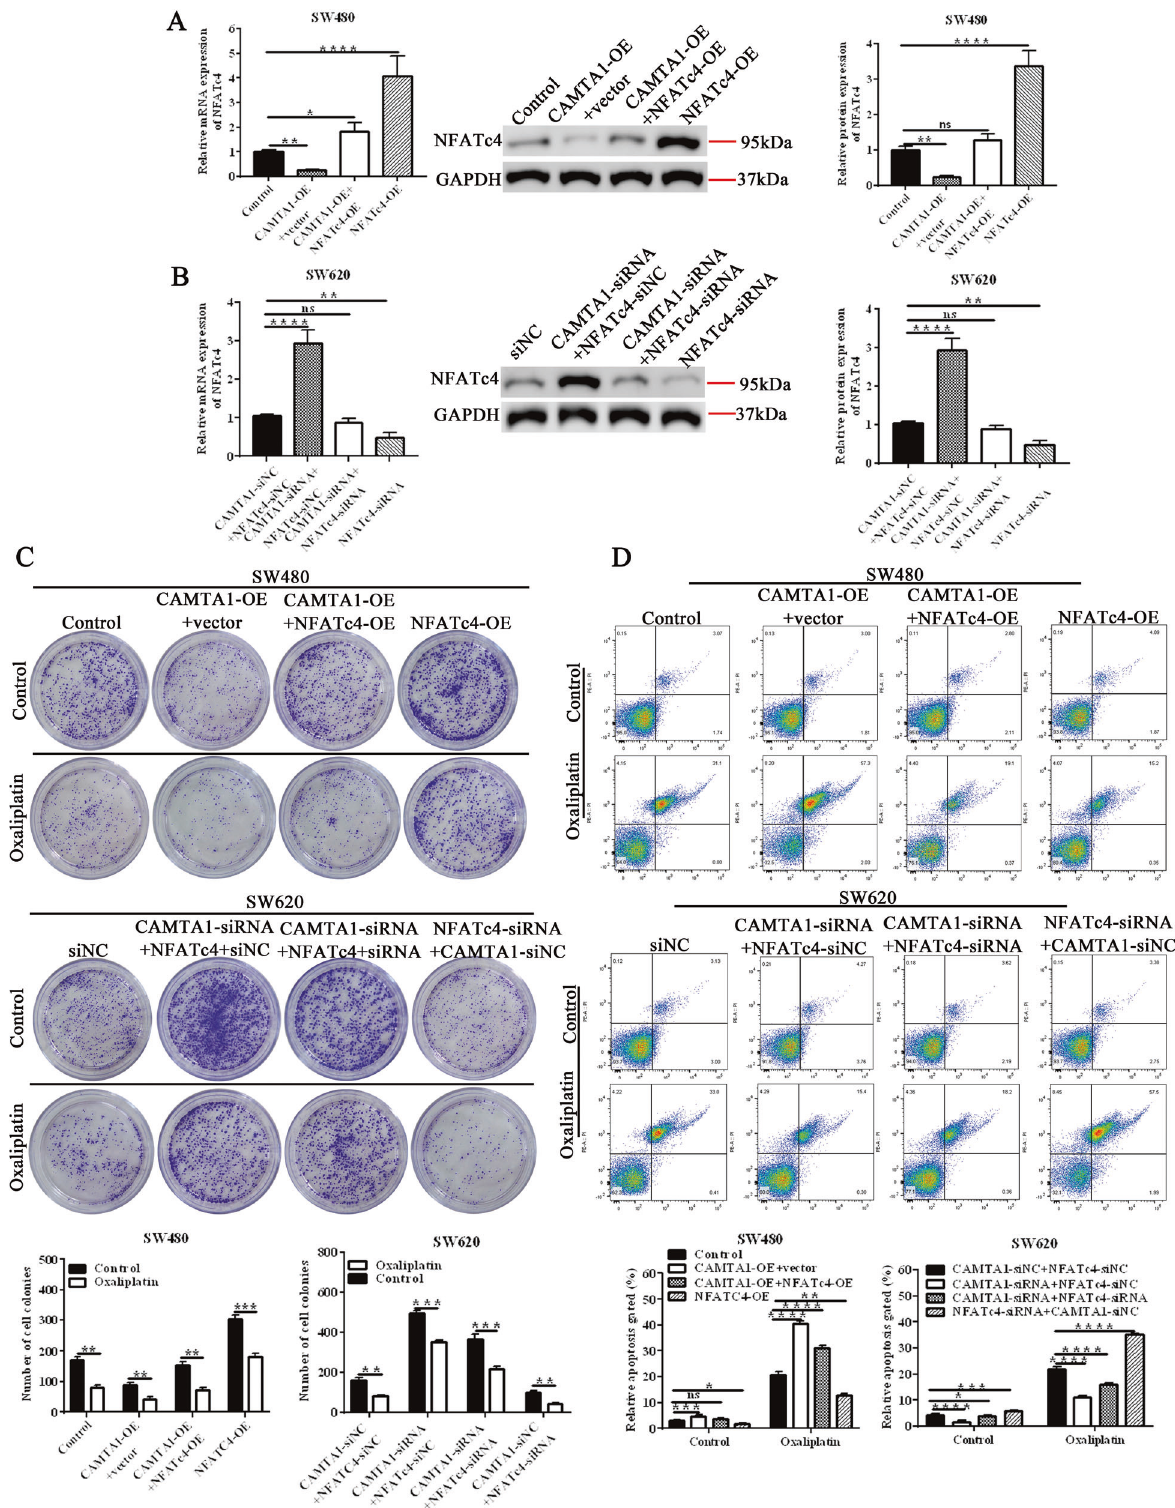
knockdown, NFATc4 knockdown, and CAMTA1 + NFATc4